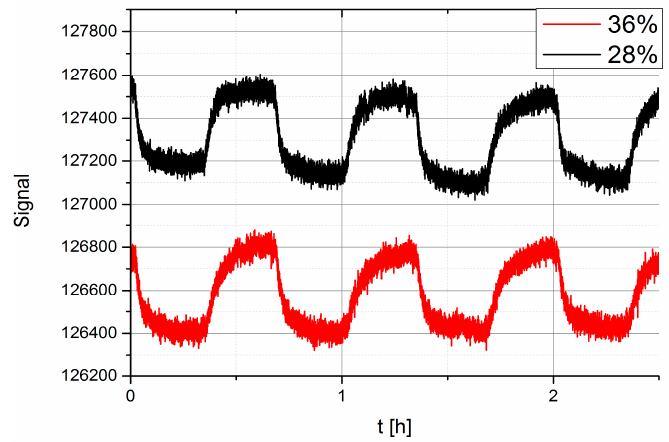
Figure 20. Comparison of the response of the EDA sensor to TNT in the presence of different water vapour background concentration of 36% and 28% respectively.